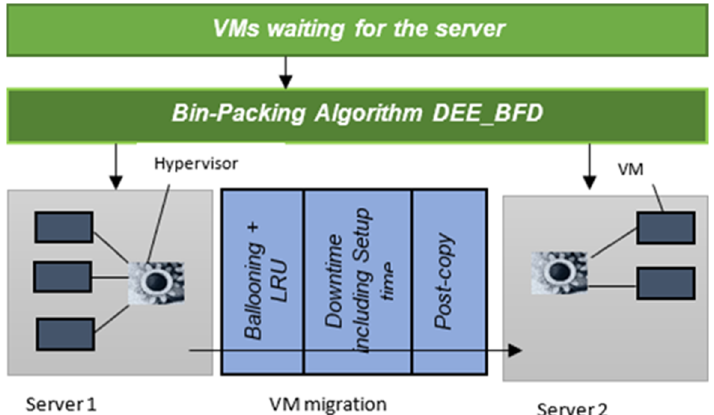
Figure 4. LMEB framework.